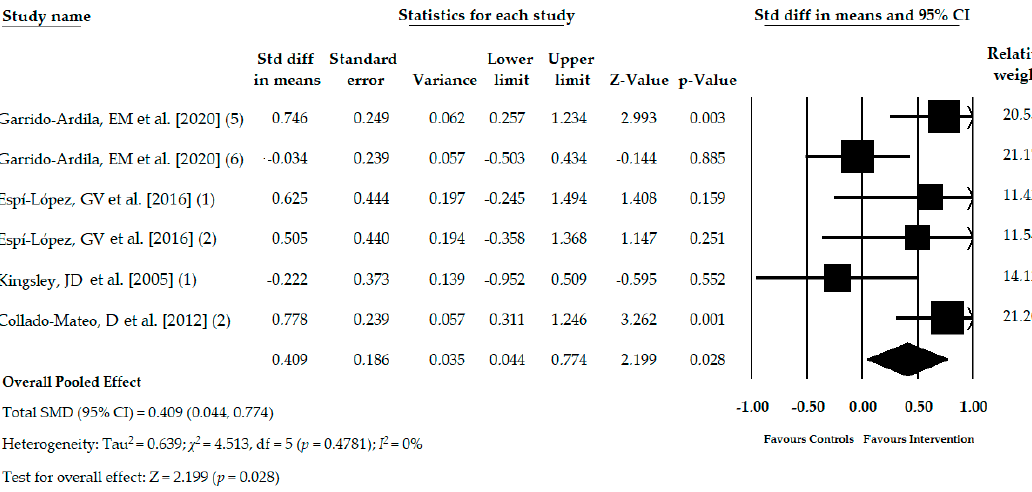
Figure 4. Forest plot of the meta-analysis of the immediate effect of the ATBT in functional balance.